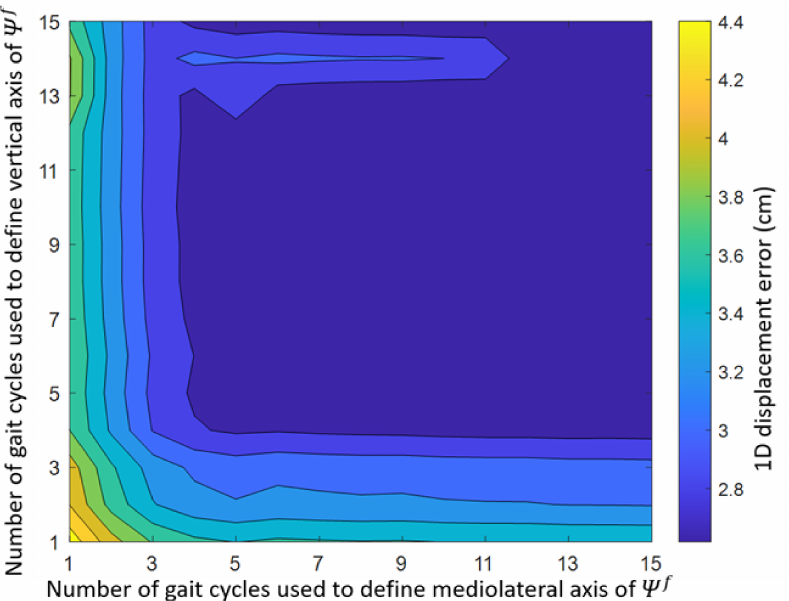
Figure 8. Effect of the number of gait cycles used to determine the mediolateral Equation (4a) and vertical axis Equation (4b) of Ψ f on the 1D displacement error between DFOD and